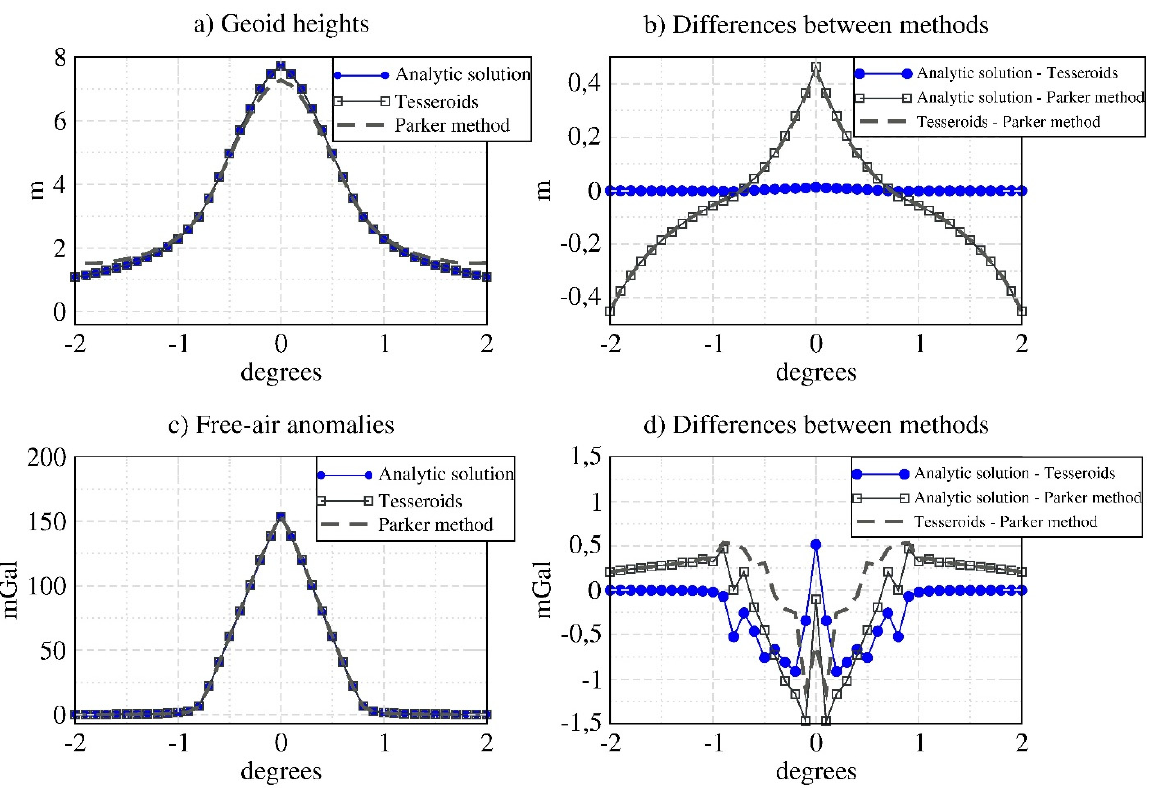
Figure 5. Forward problem estimates. Comparison of analytic solution derived from radial integra- tion with respect Parker method, tesseroids approach using Taylor series expansion for geoid heights [54] and the software developed by [55] for free-air anomalies. Geoid heights ( a ) and differ- ences ( b ); free-air anomalies ( c ) and differences ( d ).